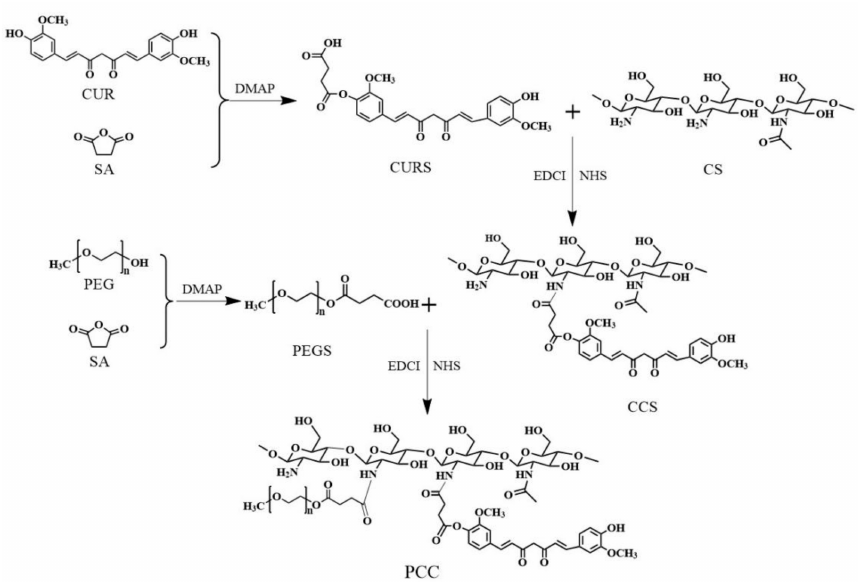
Figure 1. The chemical synthesis of Polyethylene glycolated (PEGylated)curcumin-grafted-chitosan